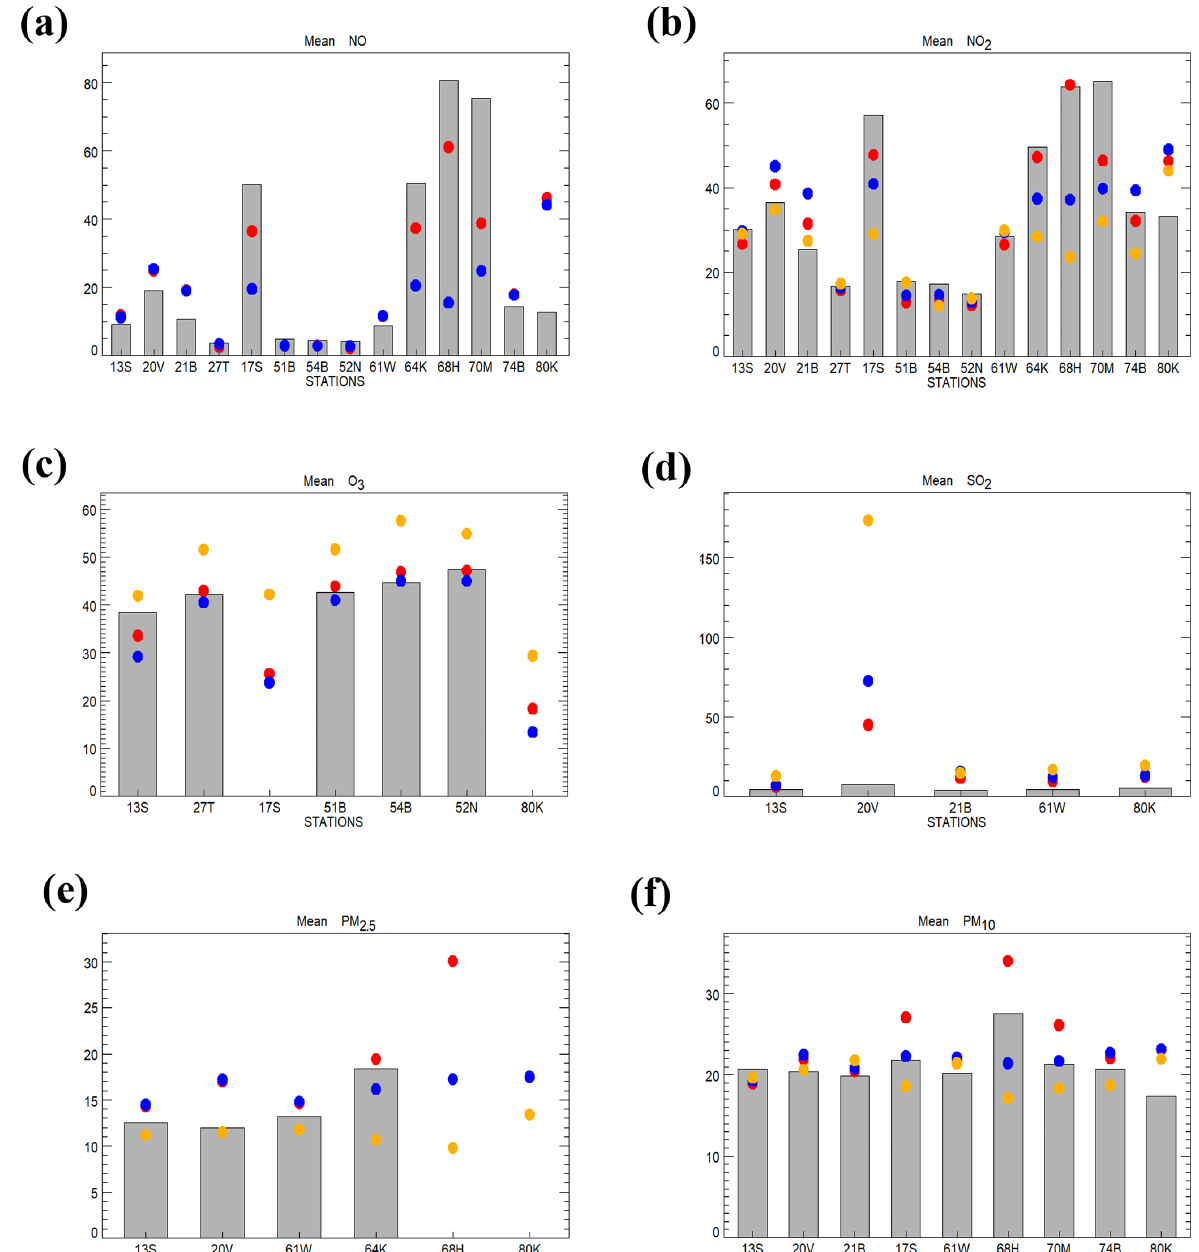
Figure 7. Bar plots comparing modelled and observed mean annual concentrations (µgm − 3 ) for monitoring stations in the Hamburg AQ network: (a) NO, (b) NO 2 , (c) O 3 , (d) SO 2 , (e) PM 2 . 5 and (f) PM 10 . Observed values are represented as grey filled bars, and modelled values from EPISODE–CityChem, standard EPISODE and TAPM are indicated as red, blue and orange filled circles, respectively. Observation data not shown for stations for which data completeness was less than 75% (for O 3 : 17SM and 80KT, for PM 2 . 5 : 68HB and 80KT). TAPM does not output NO concentrations. Non-visible data points of EPISODE–CityChem overlap